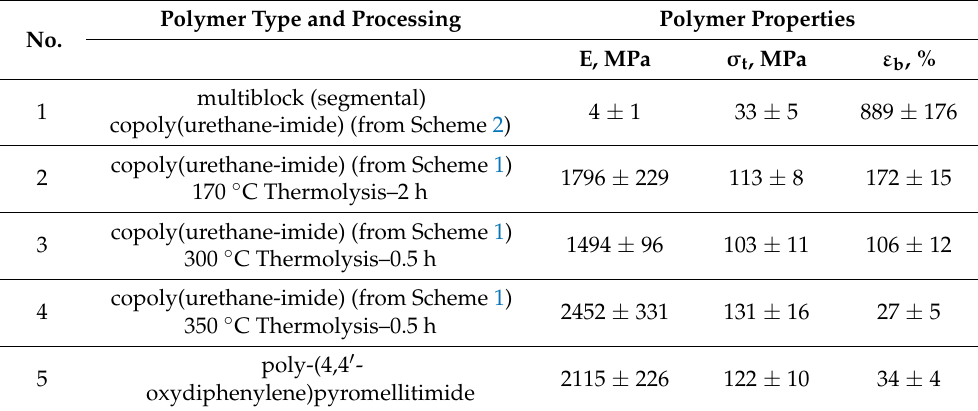
Table 1. Deformation–strength properties of copoly(urethane-imide) films heated for 30 min at the specified temperatures.